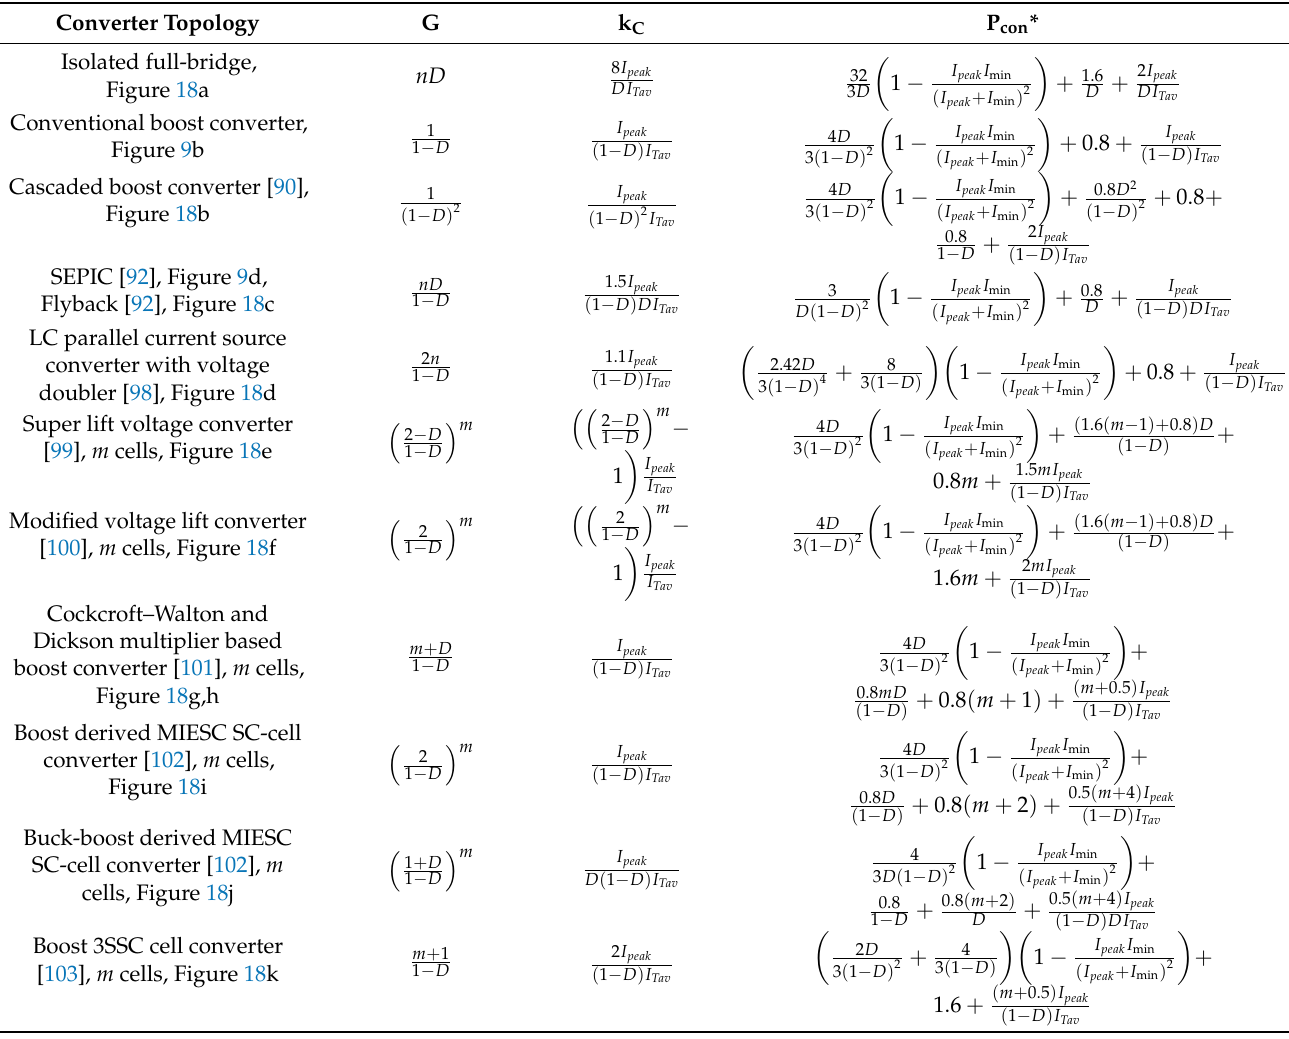
Table 8. High voltage gain converters: comparative